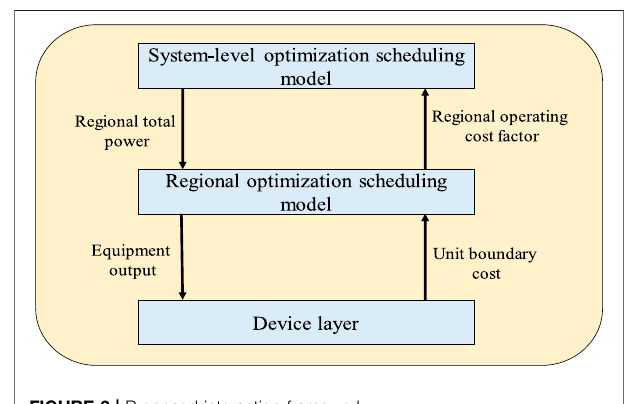
FIGURE 3 | Proposed interaction